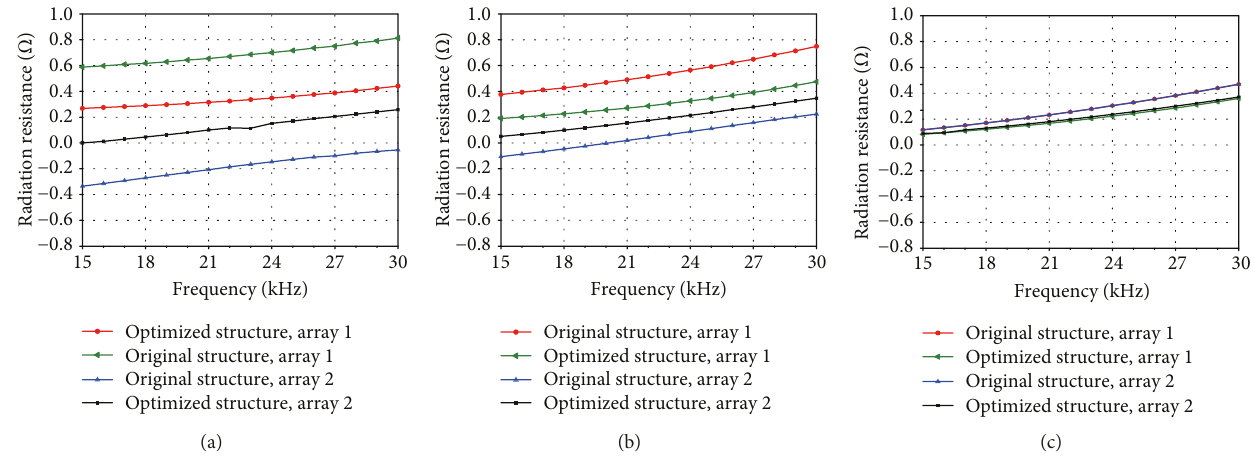
Figure 11: Radiation resistances of the VLF umbrella arrays for di ff erent beam positions: (a) 0 ° (180 ° ) beam position; (b) 60 ° (120 ° ) beam position; (c) 90 ° (270 ° ) beam position.